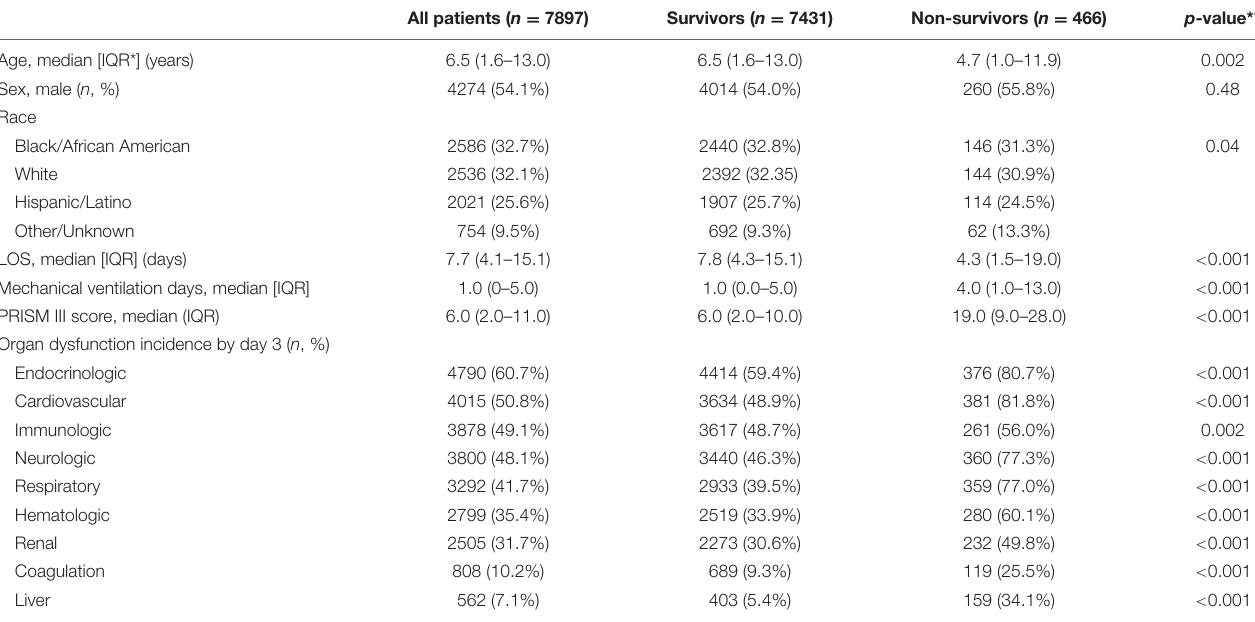
TABLE 1 | Demographics of patients with organ dysfunction by day 3 of PICU